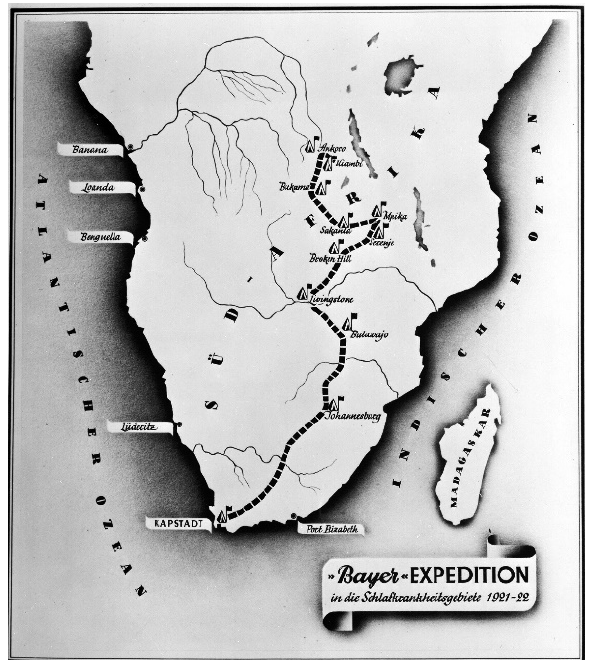
Figure 1. (Bayer Archive. 1921. (Picture 0-19682)) Route of the Bayer expedition starting on 2 November 1921 in Cape Town, travelling to the areas most affected by African sleeping sickness in what is today Tanzania, Burundi, Ruanda, DR Congo as well as a small part of Mozambique, Zimbabwe and Zambia, where the expedition ended in Kiambi in late 1922.